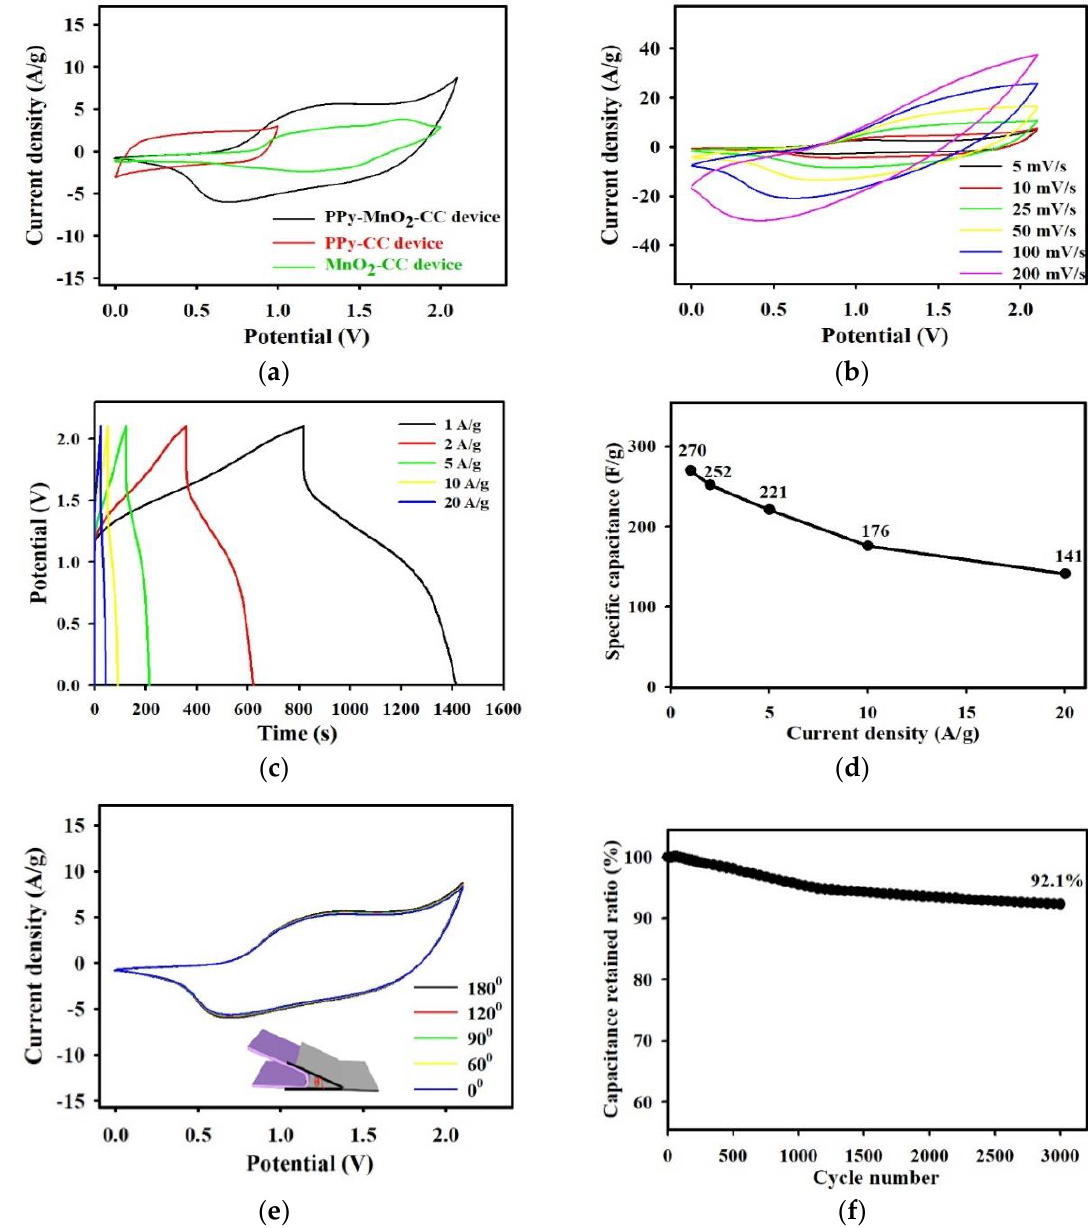
Figure 5. ( a ) CV curves of the PPy-MnO 2 -CC, PPy-CC and MnO 2 -CC flexible SSC recorded with the urea-LiClO 4 -PVA gel electrolyte (10 mv/s). ( b ) CV curve of the PPy-MnO 2 -CC flexible SSC device at various scan rates. ( c ) GCD curves of the flexible SSC device at various current densities (1 – 20 A/g). ( d ) C sp of the flexible SSC device as a function of current density. ( e ) CV curves of the flexible SSC device at different bending states (10 mV/s). ( f ) Cycle stability of the flexible SSC device at 5 A/g.